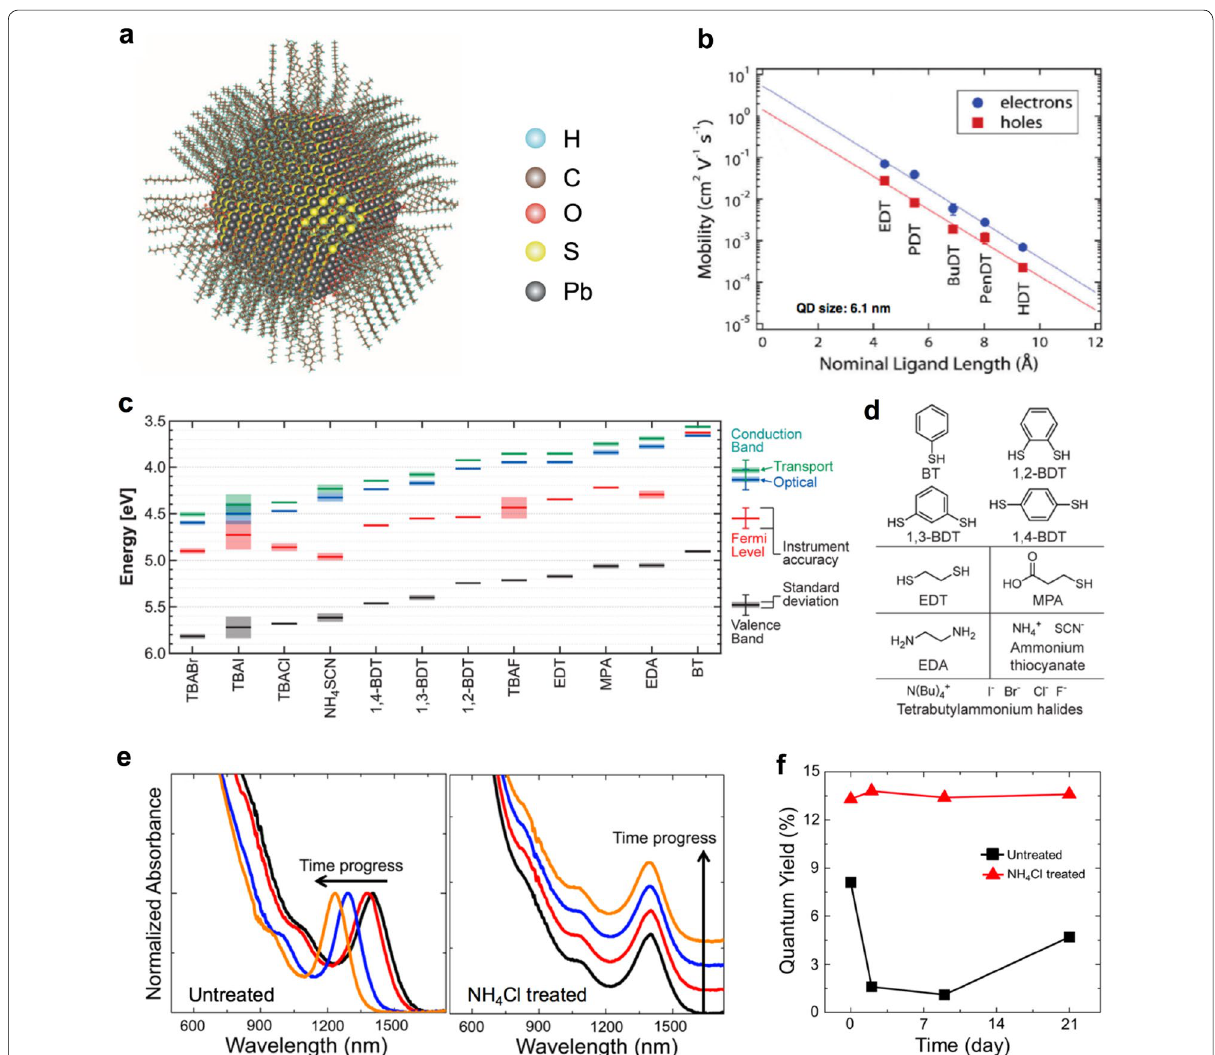
Fig. 2 a Schematic diagram of a PbS CQD consisting of a semiconductor core and surface ligands (reprinted with permission from ref. 8, Copy- right 2014 American Association for the Advancement of Science). b Charge carrier mobility of PbS CQD films with various surface ligand